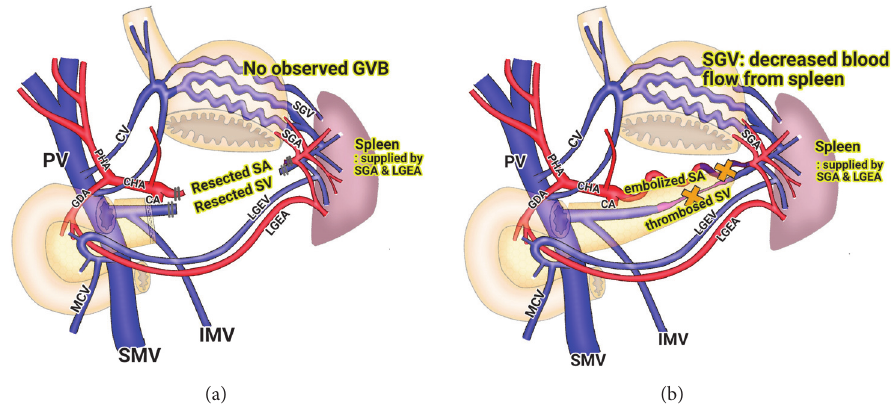
Figure6:(a)AftertheWarshawoperation,spleenissuppliedbyshortgastricarteriesandleftgastroepiploicarteryanddrainedbyshortgastric veins and left gastroepiploic vein. No gastric variceal bleeding was observed after the operation over 20 years of observation period. (b) After splenic artery embolization, pressure within short gastric veins is decreased. The blood flow of spleen is maintained similar to postoperative circumstance of the Warshaw operation. PV, portal vein; SMV, superior mesenteric vein; CV, coronary vein; IMV, inferior mesenteric vein; SA, splenic artery; SV, splenic vein; LGEA, left gastroepiploic artery; LGEV, left gastroepiploic vein; SGA, short gastric artery; SGV, short gastric vein; GVB, gastric variceal